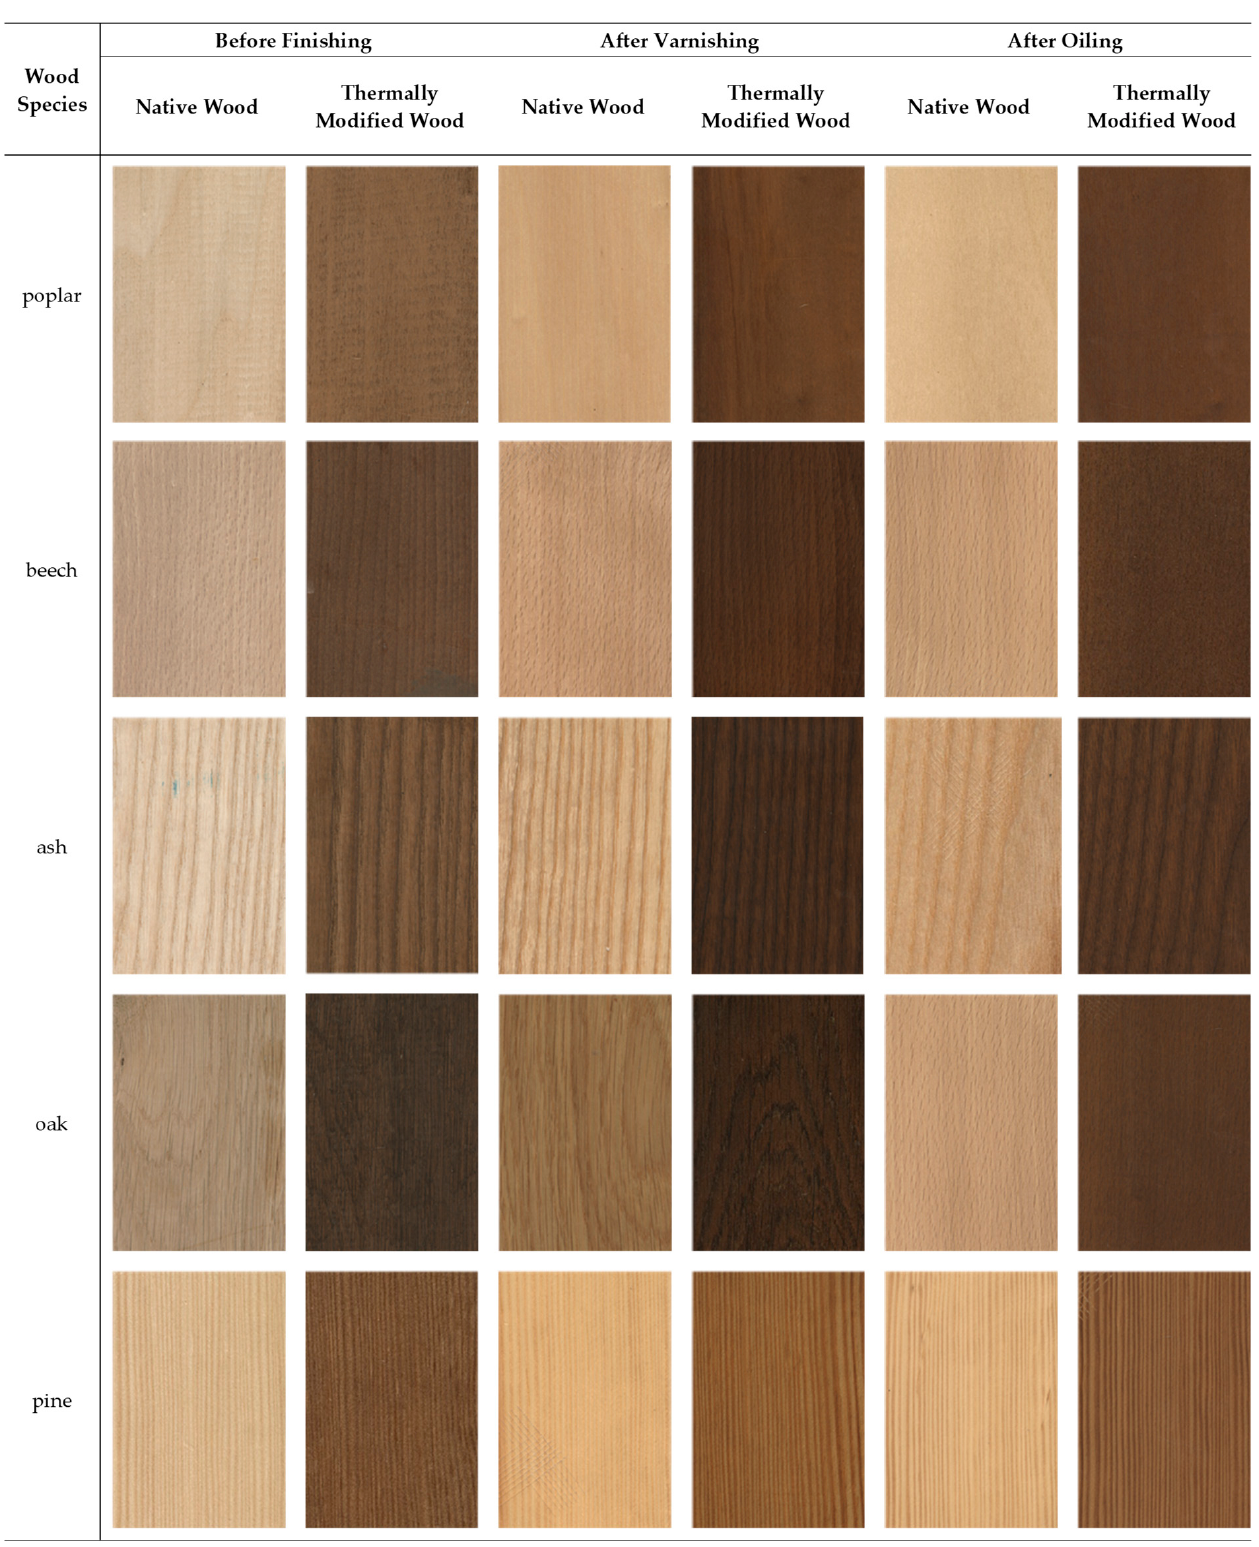
Figure 4. Native and thermally modified wood before and after varnishing and oiling.